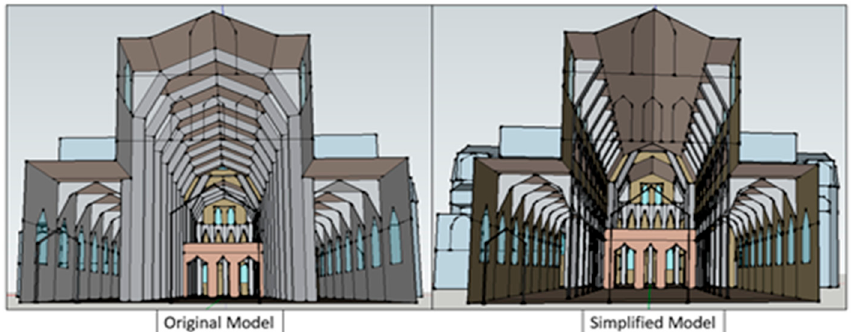
Figure 4. Original vs. simplified model comparison.